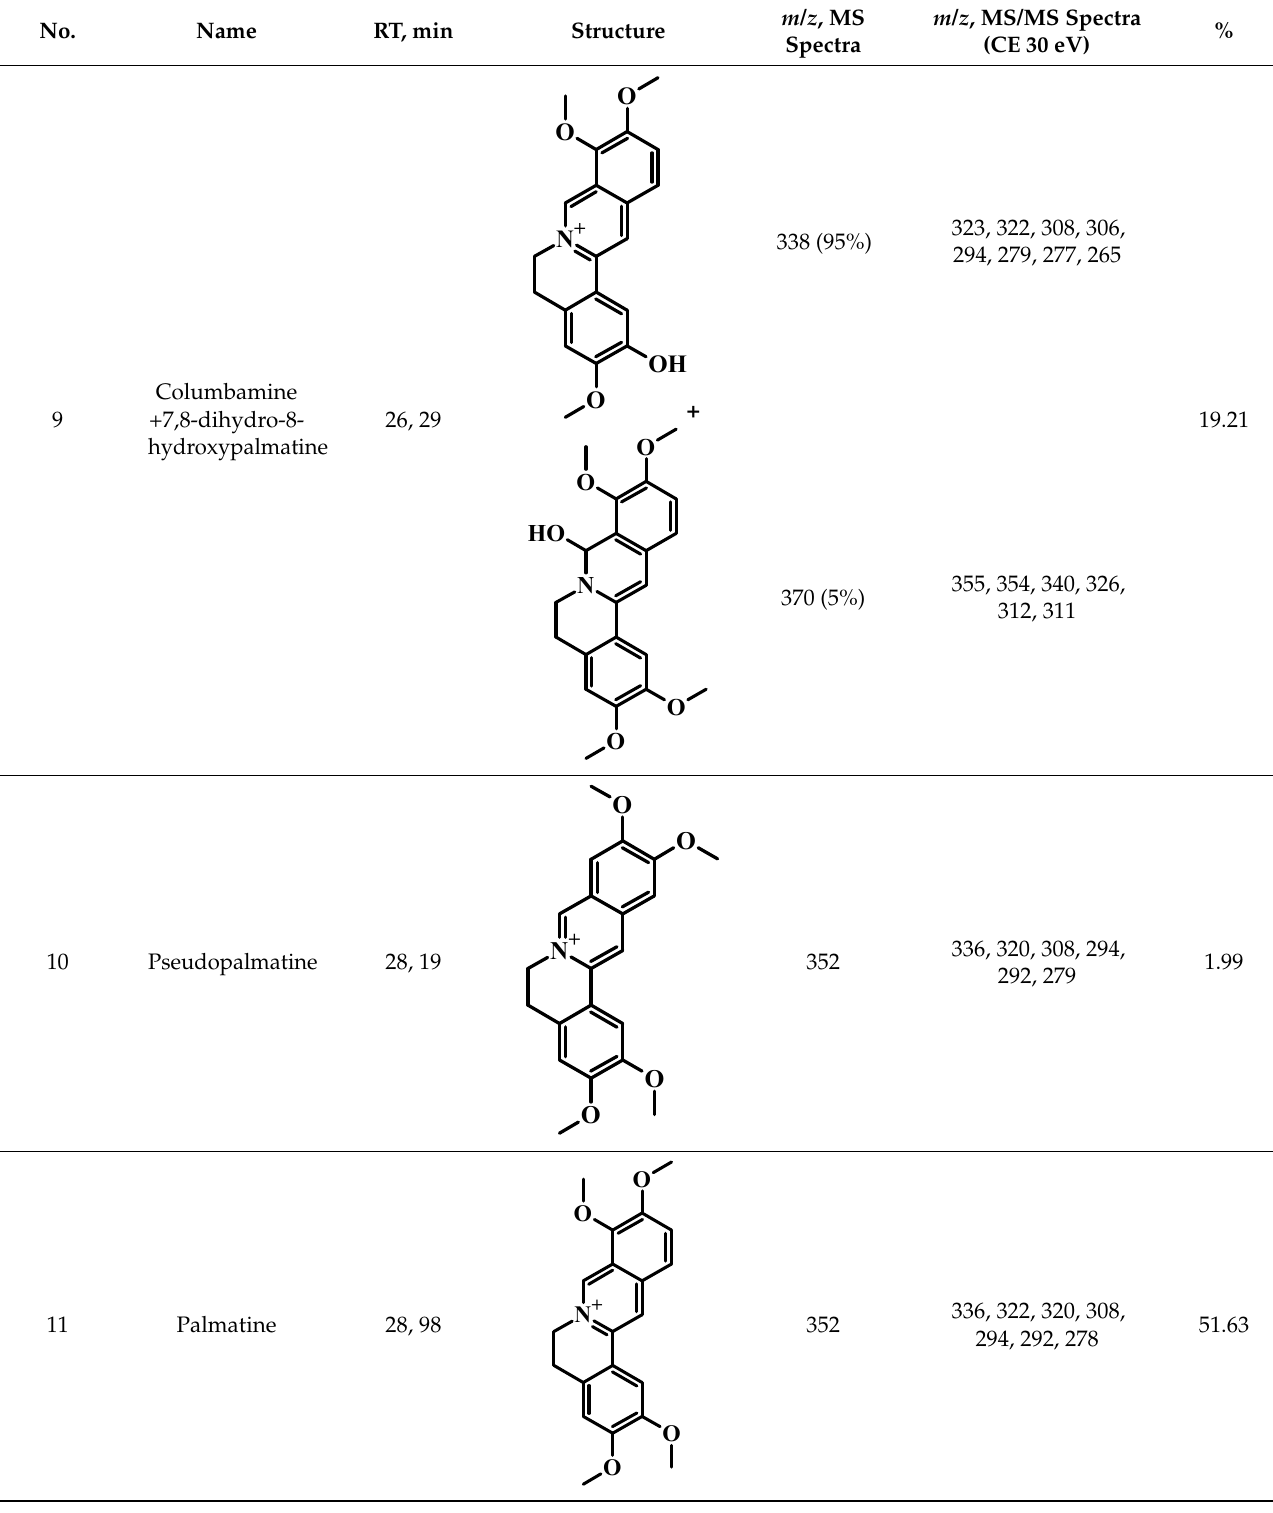
Table 6. Mineral composition of optimized ethanolic bark extract of Enantia chlorantha.